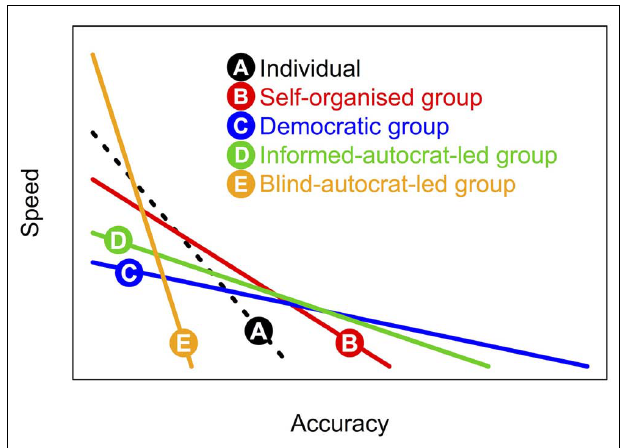
FIGURE 2 | Speed-accuracy trade-offs under different forms of decision-making. Different forms of decision-making (1–5) are inherently variable in terms of accuracy (or fairness). For the above illustration we assume the pattern C > D > B > A > E with regard to accuracy. Moreover, the different forms require relatively more or less time for (i) investigation of available options; (ii) assimilation of social information, (iii) deliberation/ computation, and finally, (iv) implementation. Here, we assumed the following time costs across decision-making forms A–E: for step (i): 3,2,1,1,1; (ii): 0,1,3,3,0, (iii): 0, 3,1,1,0, and (iv):